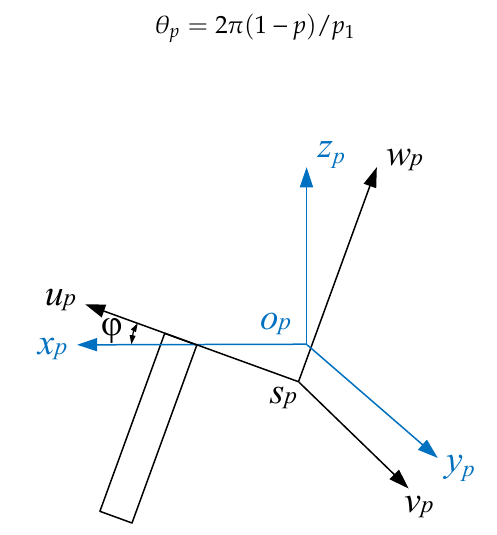
Figure 5. A single pole in the ( s p - u p , v p , w p ) coordinate system and ( o p - x p , y p , z p ) coordinate system.